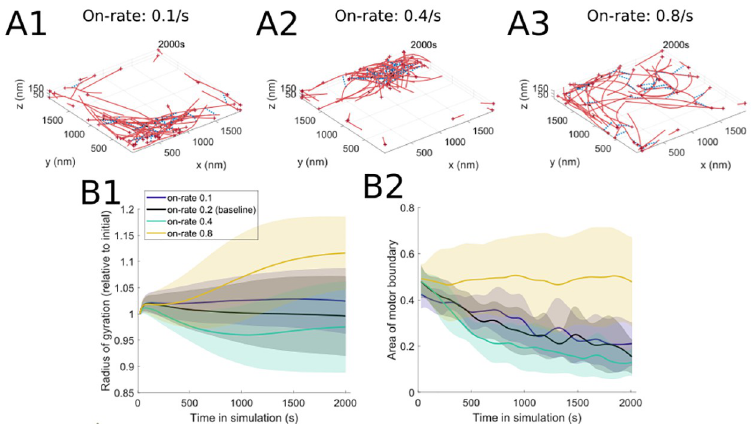
Fig 6. Motor protein binding on-rate has a nonlinear effect on actomyosin organization, with high and low rates resulting in a loose meshwork. (A) Final simulation snapshots ( t = 2000s) for different myosin binding on-rates ((A1): 0.1/s, (A2): 0.4/s, (A3): 0.8/s). (B) Characterizing the actin and myosin time-series organization in simulations with varying myosin on-rates. (B1) The radius of gyration reflects the nonlinear impact of binding on-rate, with intermediate values resulting in a more clustered organization. (B2) Similarly, the polygon boundary is smallest for intermediate binding on-rate values. The parameter values used are d step = 6 nm, F s = 100 pN, range heads = 15–30 (see Table 1). Solid lines indicate the average and shaded areas indicate the standard deviation over 10 stochastic runs indicating high variability between different runs. See Fig 3 for additional measure details.